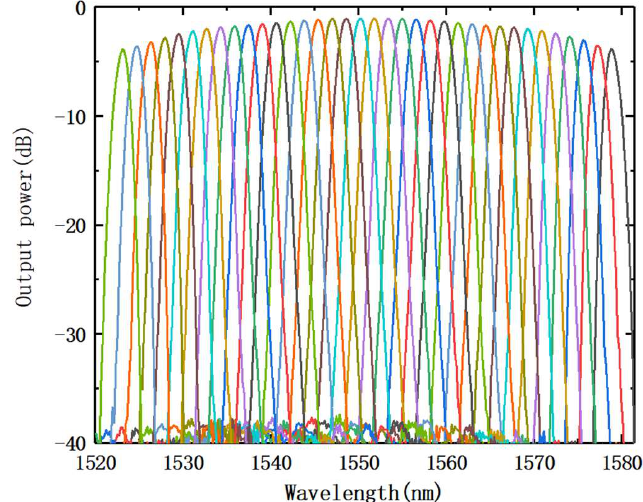
Figure 5. Simulated transmission spectrum of AWG.